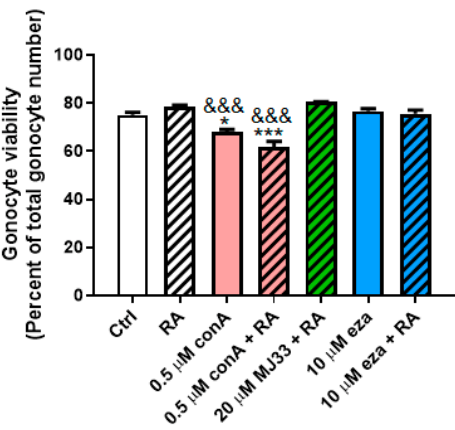
Figure 6. Effects of trans-retinoic acid (RA) and PRDX inhibitors on PND3 gonocyte viability. RA (1 μ M) and PRDX inhibitors at the indicated concentrations were added alone or together for two hours on gonocytes. Cell viability was determined by the trypan blue exclusion method. Results represent the means ± SEM from at least 3 experiments. Statistical significance: * p ≤ 0.05, *** p ≤ 0.001, treatment against control; &&& p ≤ 0.001, treatment against RA alone.